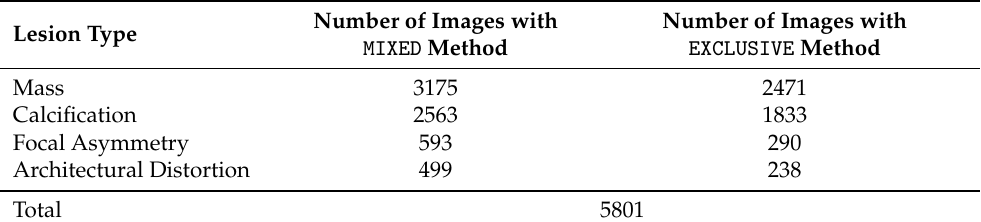
Table 1. Numbers of images for each lesion using both MIXED and EXCLUSIVE method for image selection. Number of Images with Number of Images with Lesion Type MIXED Method EXCLUSIVE Method Mass 3175 2471 Calcification 2563 1833 Focal